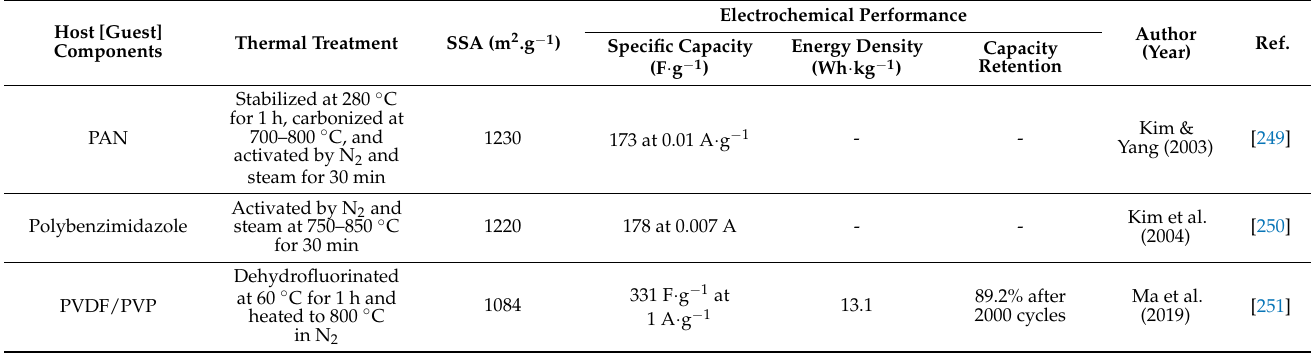
Figure 11. Preparation steps of hollow-porous multilayered ultrafine carbon fibers. Reprinted from [247], with permission from Elsevier. Table 5. Electrospun carbon nanofibers as supercapacitor electrode material.